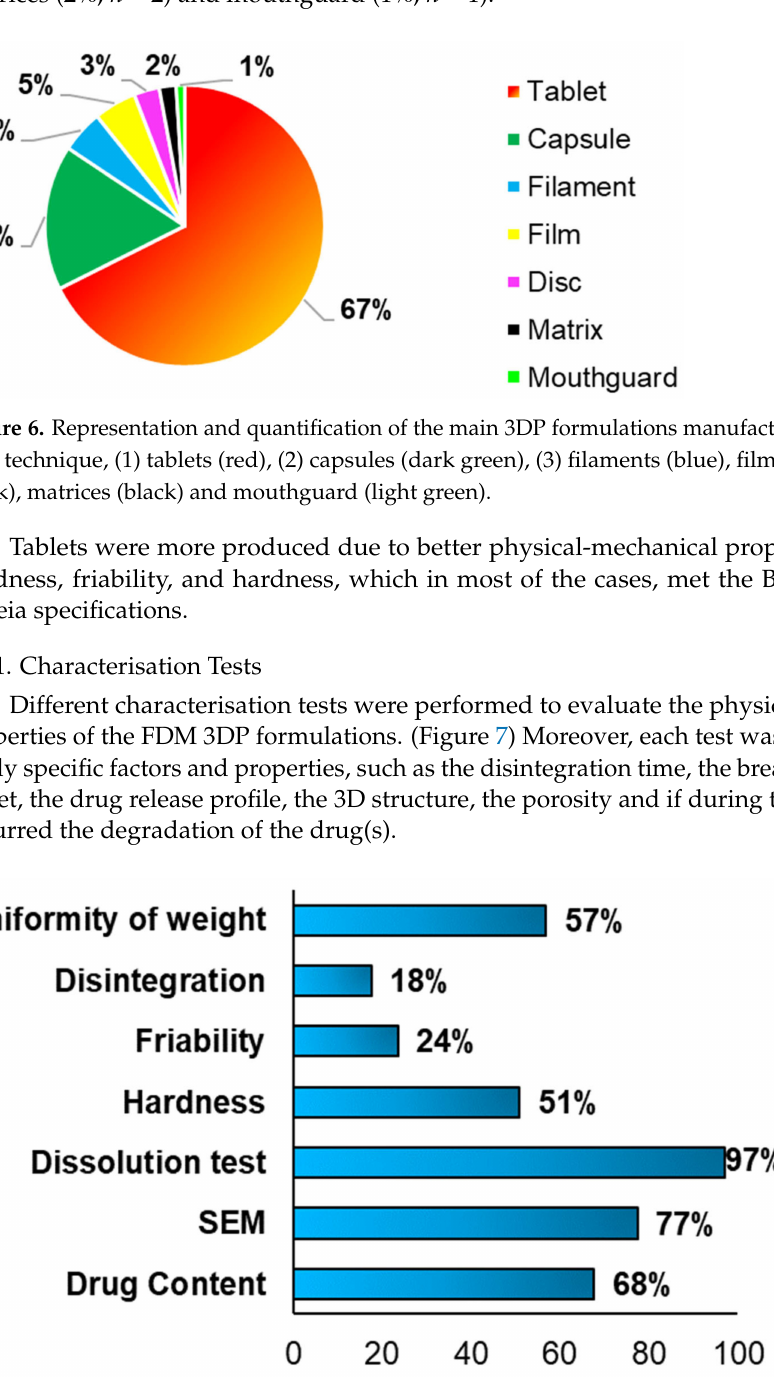
Figure 7. Quantification of the number (%) of FDM articles where the different characterisation tests, (1) uniformity of weight, (2) disintegration, (3) friability, (4) hardness, (5) dissolution test, (6) SEM and (7) drug content, were performed following the British Pharmacopeia